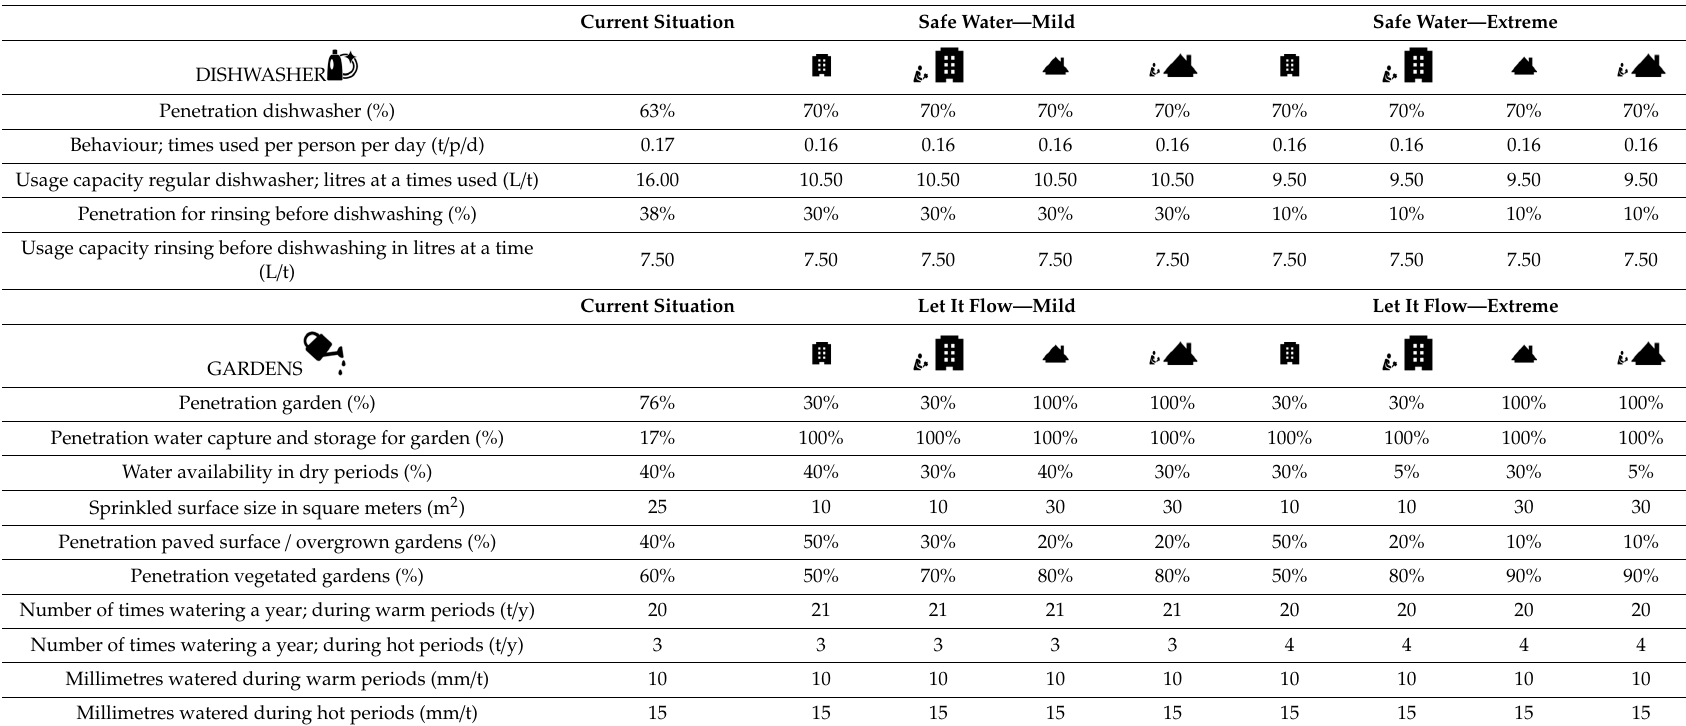
Table A3. Quantitative input data for individual water demands (STEP 6).